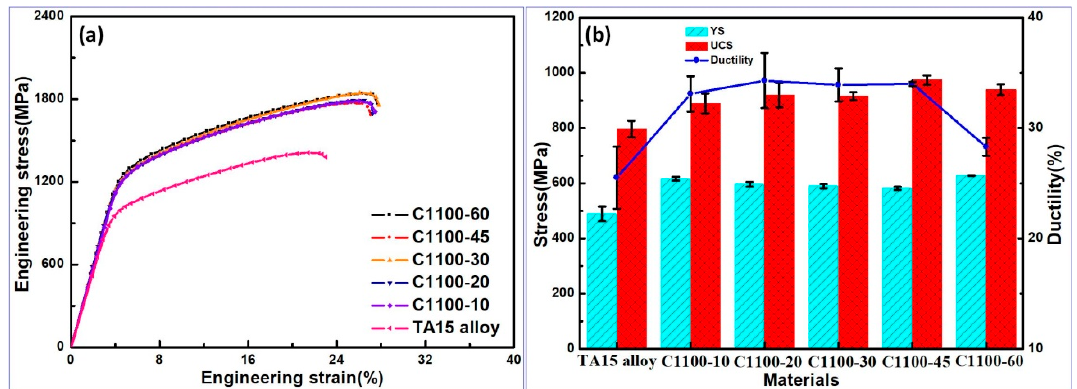
Figure 8. The compressive engineering stress–strain curves of the composites sintered at 1100 °C for different holding times and TA15 titanium alloy: ( a ) ambient temperature; ( b ) 600 °C.